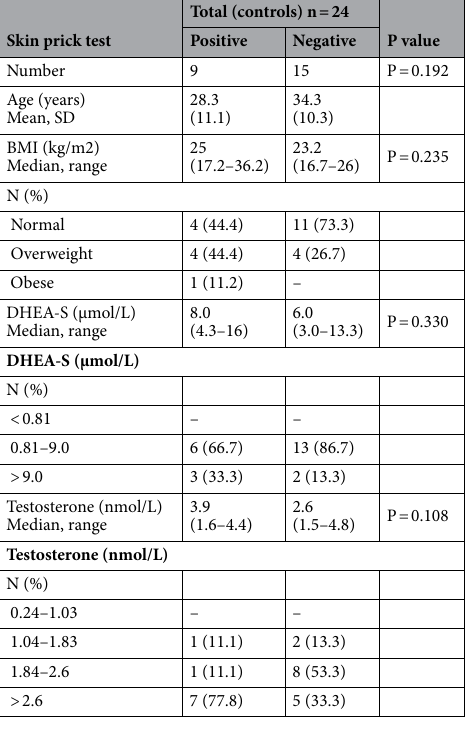
Table 2. Relationship between age, BMI, serum testosterone and DHEA-S concentration in skin-prick-tested healthy subjects. n—number of subjects; DHEA-S—dehydroepiandrosterone sulfate; Rh—allergic rhinitis; A/ Rh—allergic asthma with rhinitis; Derm/urtic—allergic dermatitis/acute urticaria; BMI—body mass index (normal = 18.5–24.9 kg/m 2 , overweight = 25–29.9 kg/m 2 , obese > 30 kg/m 2